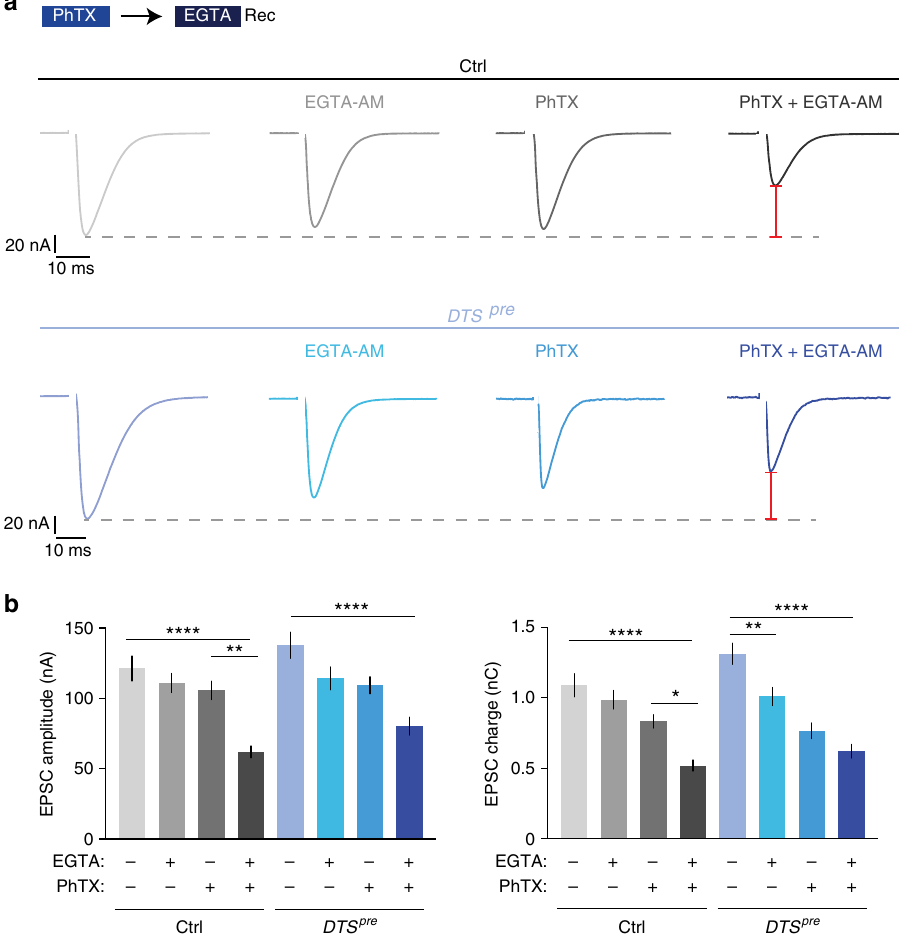
Fig. 5 Glutamate receptor perturbation and proteasome perturbation enhance release of EGTA-sensitive vesicles. a Representative EPSC traces of control ( elav C155 , ’ ctrl ’ ) and DTS pre ( elav C155 -Gal4;UAS-DTS5 ; ‘ DTS pre ’ ) synapses. The two left EPSC traces from each genotype were recorded from synapses